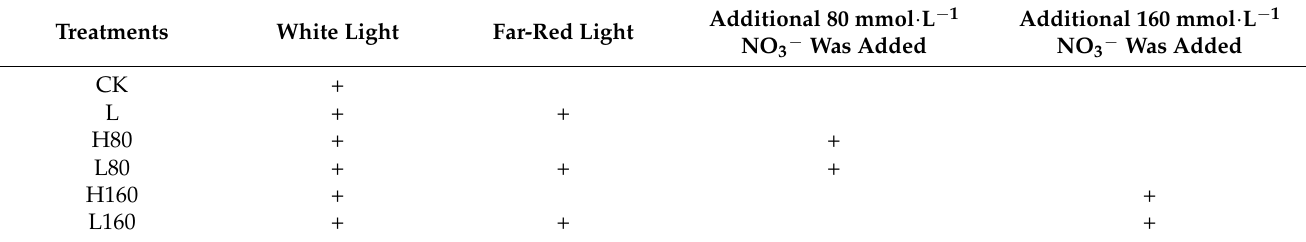
Table 1. Experimental